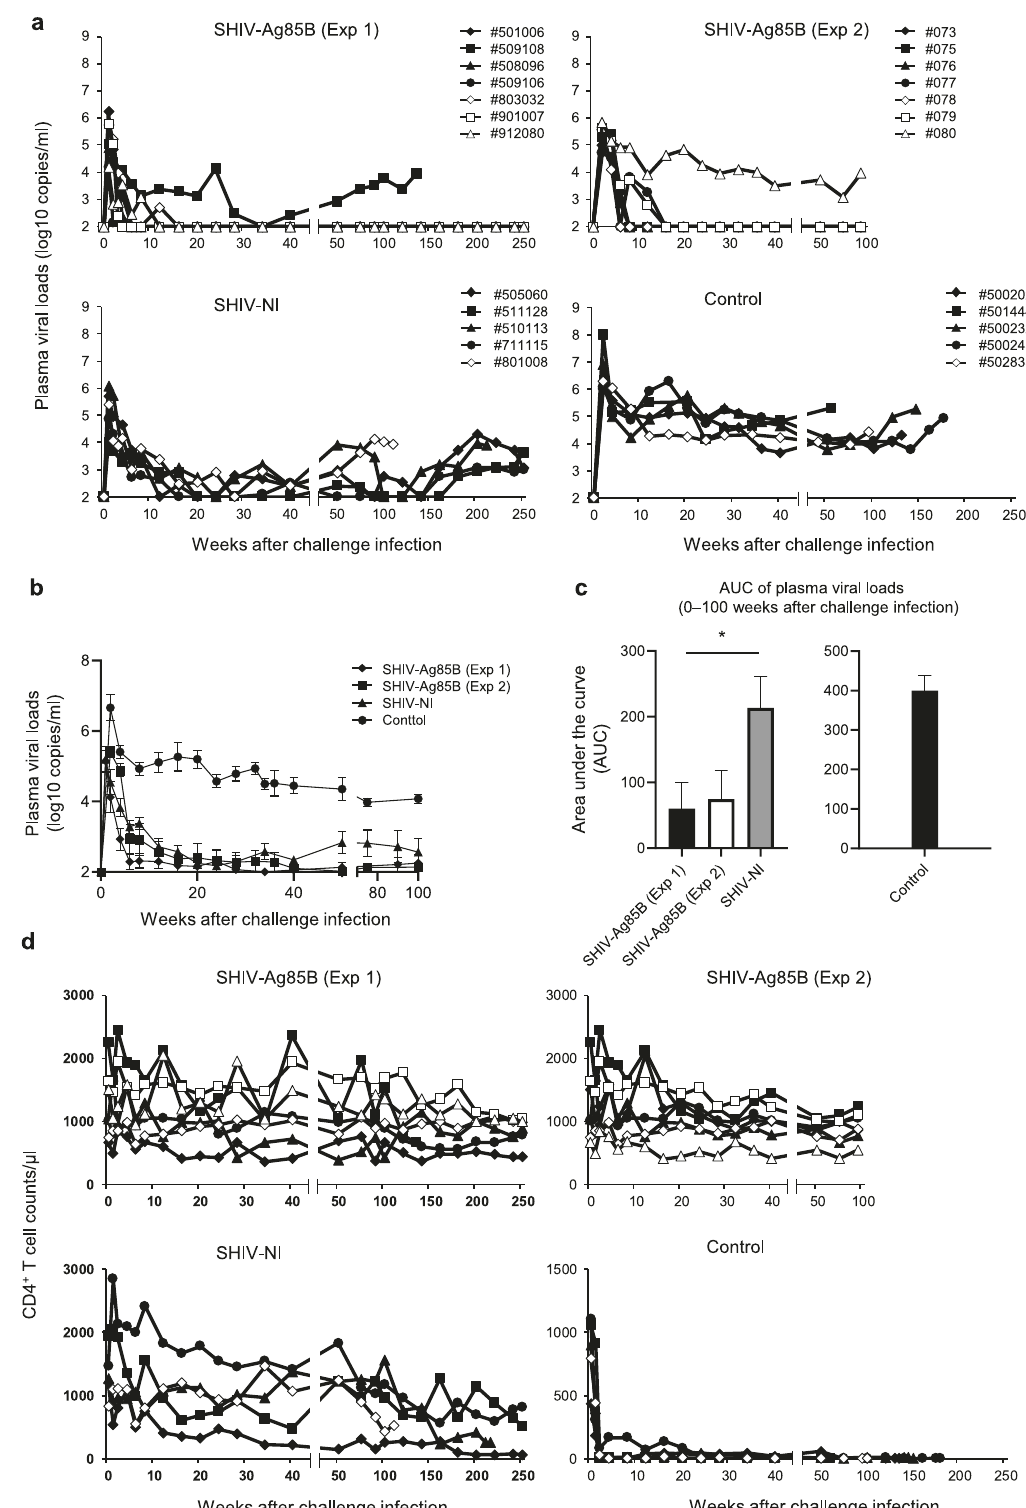
Fig. 4 Kinetics of viral loads, CD4 + T cells, and proviral DNA in macaques inoculated with SHIV-Ag85B or SHIV-NI after pathogenic SHIV89.6P challenge. a Plasma viral loads in macaques inoculated with SHIV-Ag85B (Exp 1), SHIV-Ag85B (Exp 2), and SHIV-NI after SHIV89.6P challenge. As controls, 5 naive macaques were challenged intravenously with SHIV89.6P. Plasma viral loads were measured by quantitative RT- PCR. The detection limit of plasma viral load was 100 copies/ml. b Mean plasma viral loads in each group after SHIV challenge. The lines indicate each group means and error bars represent means ± SEM. c Area under curve (AUC) of plasma viral loads in each group between 0 and 100 weeks post challenge infection. Error bars represent means ± SEM. Statistical analysis was performed using Kruskal – Wallis test. * P < 0.05. d Count of CD4 + T cells was analyzed by fl ow cytometry and whole blood cell counts. Whole blood was stained by CD3, CD4, and CD8 Abs, and CD4 + T cell counts were determined by fl ow cytometric